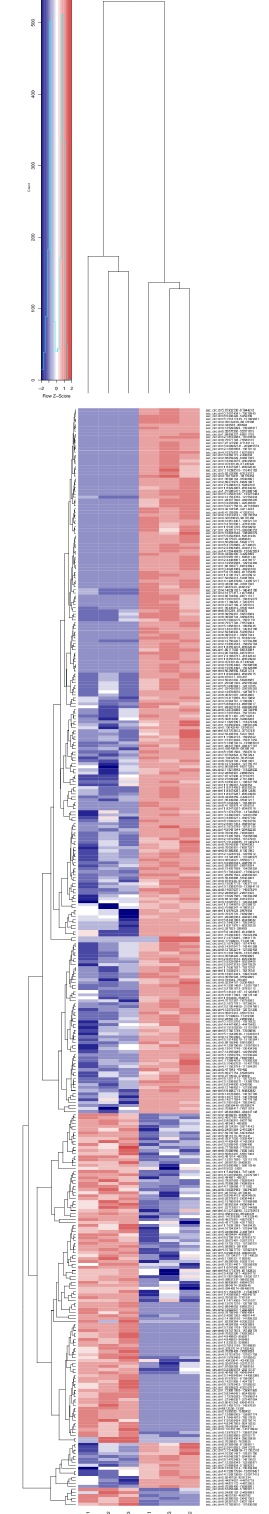
Figure 2. Hierarchical clustering of the differentially-expressed circular RNAs in the liver tissue of Jinhua and Landrace pig breeds. Red indicates relatively high expression and blue means low